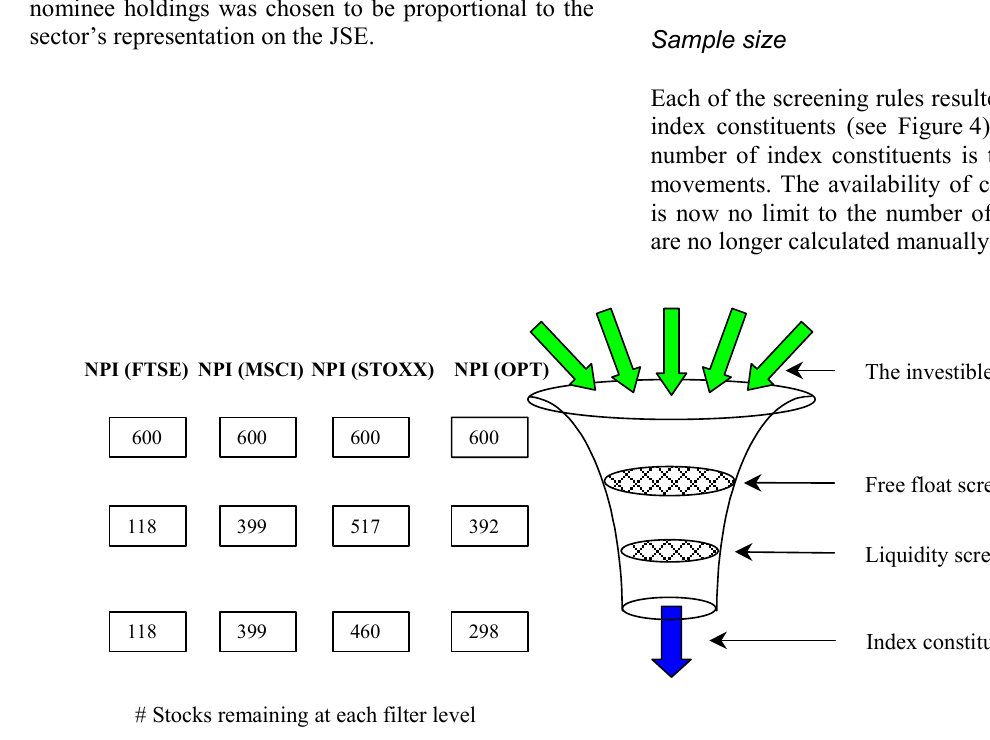
Figure 4: Effect of screening rules reducing number of index